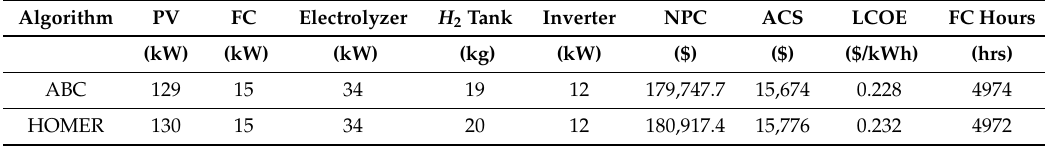
Table 2. Optimal sizing result for the proposed system obtained by the HOMER and ABC algorithms.